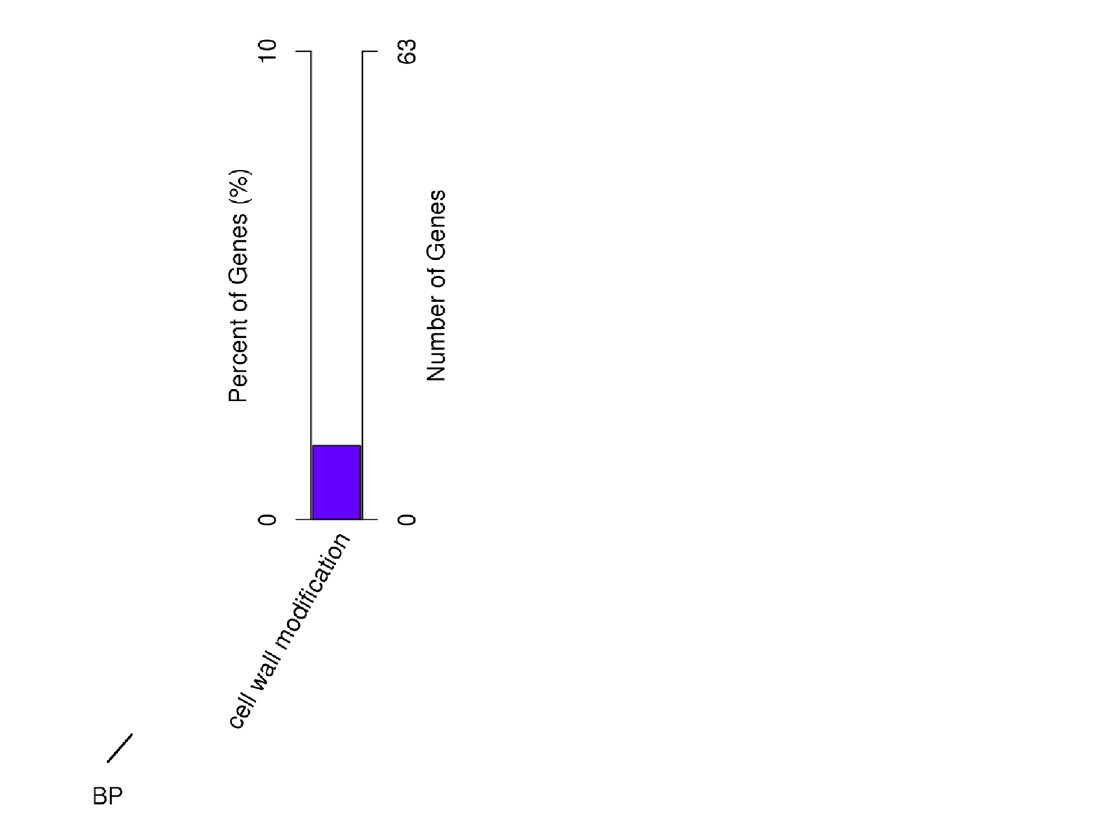
Figure 7. Gene Ontology analysis of the target genes of lncRNAs in ABA vs.